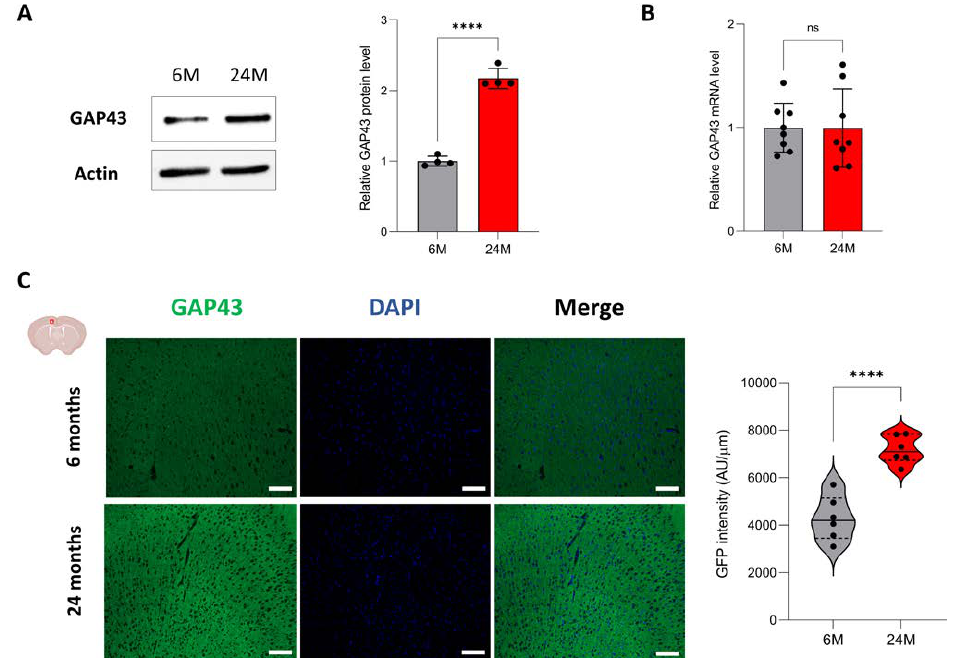
Figure 5. Analysis of GAP43 expression in the aging cortex. ( A ) Protein levels of GAP43 within the 6-month-old (grey) and 24-month-old (red) cortex samples were analyzed by Western blot (left panel). Actin was used as a loading control. On the right panel, quantification of the GAP43 signal (normalized by the actin signal) (n = 4 per age group). Results are indicated as mean ± SD. (****) p < 0.001 from unpaired t-test for equal means. ( B ) mRNA levels of GAP43 were measured by quanti- tative PCR and normalized to that of RPLP0 (n = 8 per age group). Results are indicated as mean ± SD. ( C ) GAP43 immunofluorescence on coronal cuts of 6-month-old and 24-month-old brains. Im- ages illustrate the representative staining in the cortex motor area with the GAP-43 antibody (green; left panel) and DAPI (blue; middle panel). The right image panel constitutes a merged image of GAP43 and DAPI signals. A quantitative comparative analysis of GAP43 expression (n = 6 per age group) is displayed on the right. (****) p < 0.001 from unpaired t-test for equal means. Scale bar: 100 µm. 4. Discussion As we age, the volume of the brain reduces at the rate of around 5% per decade, starting at the age of 40 [52]. In middle-aged adults, wide-spread cortical thinning has been observed, reflecting significant global atrophy [53]. However, older age is associated with greater cortical thickness in the dorsolateral and anterior cingulate cortices [54]. Our findings support this observation as we have described an increase in cortical thickness between 6 and 24 months of age (Figure 1B). There is evidence to suggest that the rela- tionship between age and cortical thickness is not a linear model, particularly for the an- terior cingulate cortex (ACC). Indeed, ACC thickness is reduced until the age of 60 but is, thereafter, greater at older ages [55]. One hypothesis to explain the “reversal” of cortical thinning could be an increase in neuroplasticity [56,57]. When the brain is damaged, older adults can maintain cognitive and body functions by activating effective compensatory resources in response to this degradation [58]. Our results support this neuroplasticity as